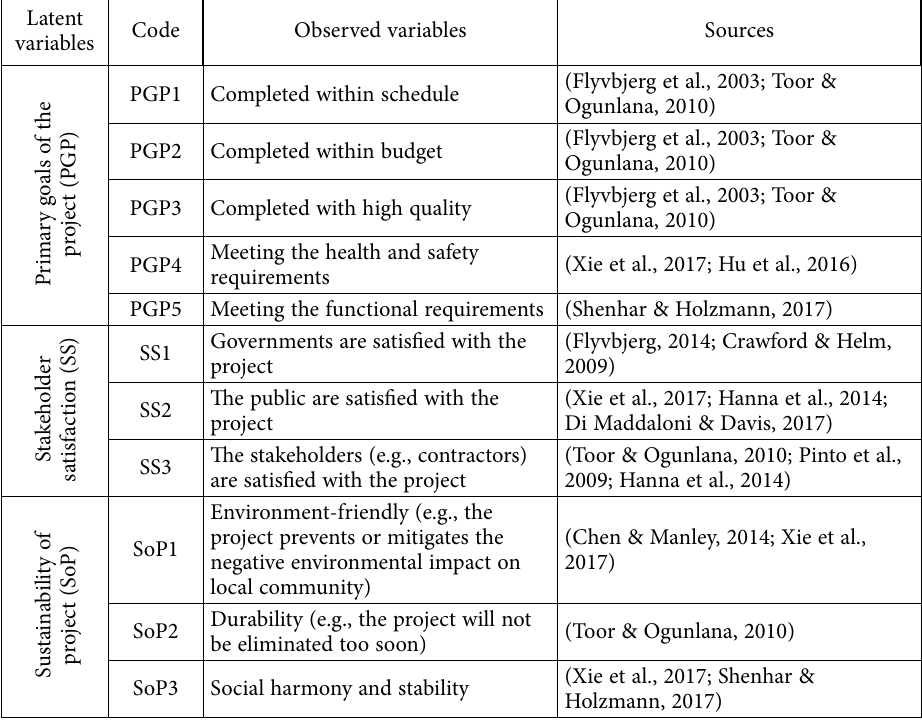
Table 2. Proposed framework of megaproject